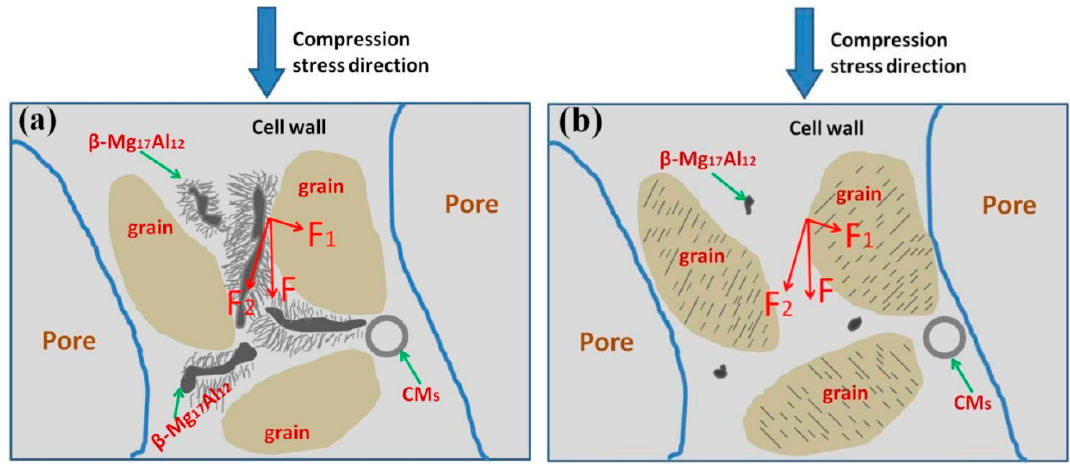
Figure 12. Schematic diagram of the generation of cracks in the unheated ( a ) and heated ( b ) composite foams.